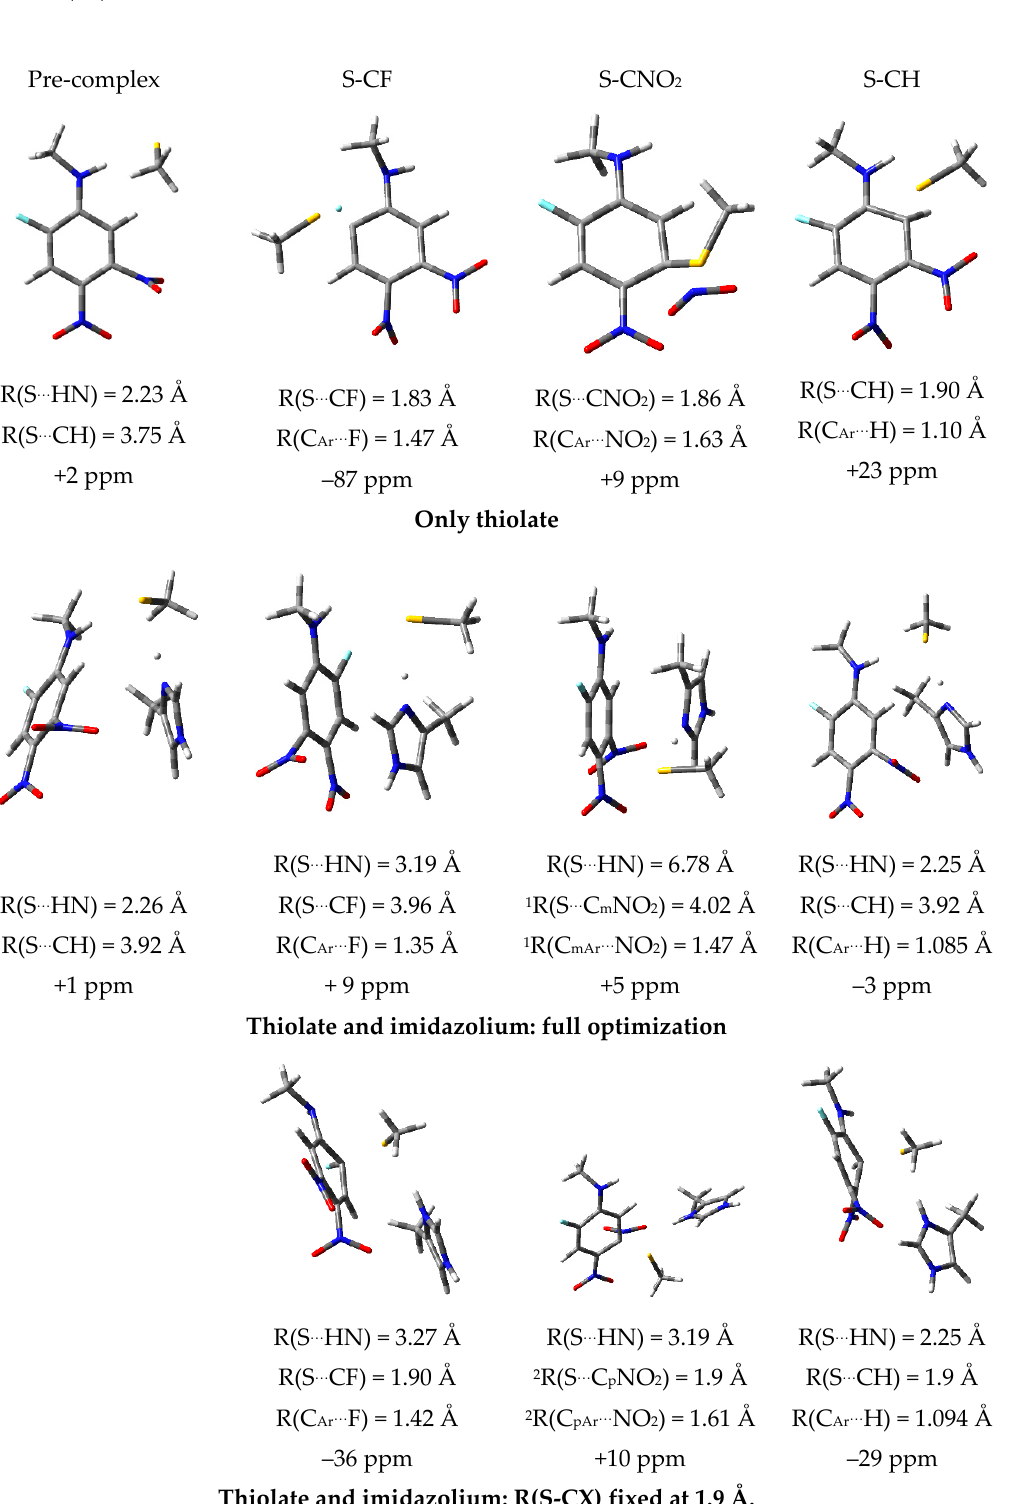
Figure 6. Computed structures and 19 F shifts relative to the 19 F shift of the free inhibitor for the di ff erent model systems. For the undistorted inhibitor the following distances are obtained: R(CAr ... F) = 1.35 Å, R(CAr ... NO 2 ) = 1.47 Å and R(CAr ... H) = 1.085 Å. For further explanation see main text; 1 with respect to the NO 2 group in meta-position to F; 2 with respect to the NO 2 group in para -position to F. MP2, second-order Møller–Plesset perturbation